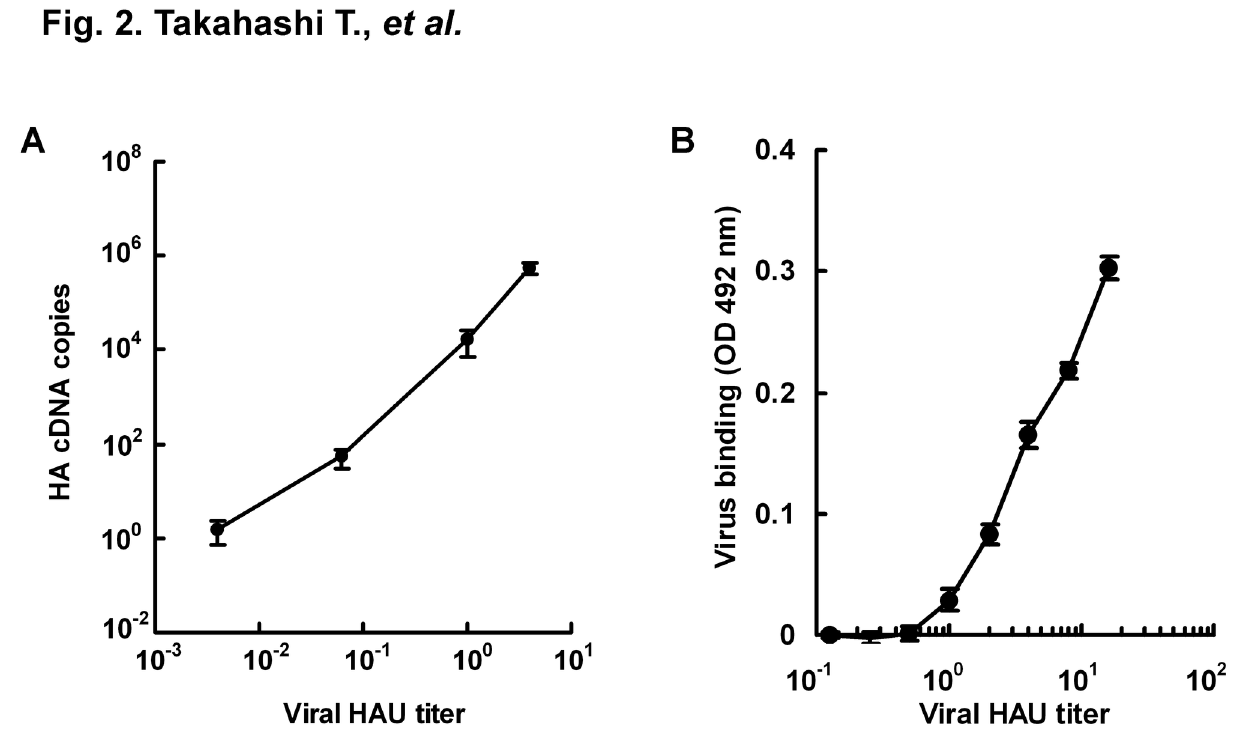
Figure 2. Detection of virus binding to α2,3PGA by real-time PCR and by solid-phase virus binding assay. A, A microplate was immobilized with 200 ng/well of α2,3PGA and then blocked with 1% lipid-free BSA in PBS at 4 °C overnight. Different titers of avian IAV D313 (2 2 , 2°, 2 -4 , and 2 -8 HAU/50 μl) were incubated for 2 h at 4 °C on microplates that were immobilized with α2,3PGA. Viral RNAs of viruses bound to α2,3PGA were extracted. Amount of HA cDNA copies was measured by using real-time PCR. Each value (S.E.) is the average from three independent experiments. Receptor binding of D313 to α2,3PGA was able to be linearly measured within the range of 2 2 to 2 -4 HAU from a correlation factor of more than 0.99. B, A microplate was immobilized with 200 ng/well of α2,3PGA and then blocked with 1% lipid-free BSA in PBS at 4 °C overnight. Different titers of avian IAV D313 (2 4 to 2 -3 HAU/50 μl) were incubated on a microplate. Viruses bound to α2,3PGA were detected by rabbit anti-D313 polyclonal